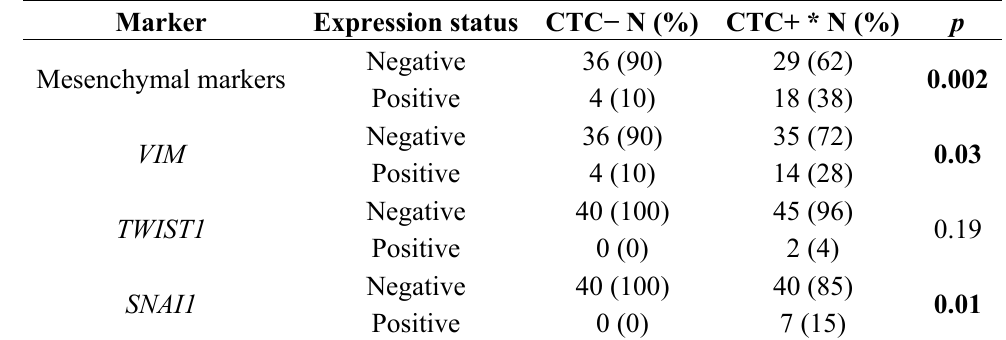
Table 1. Correlation between CTCs detection status and mesenchymal markers expression status.